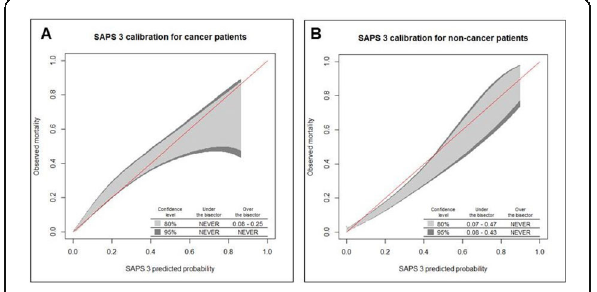
Fig. 1 (abstract 001246). See text for